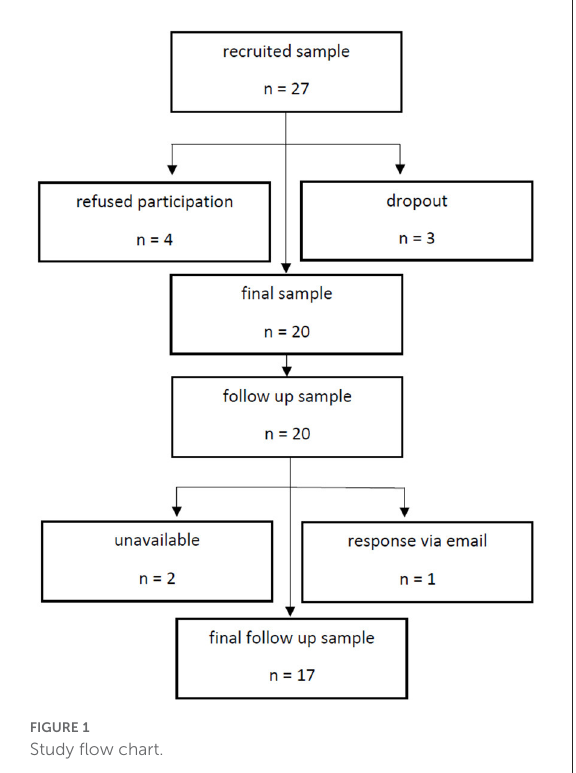
FIGURE1 Study flow